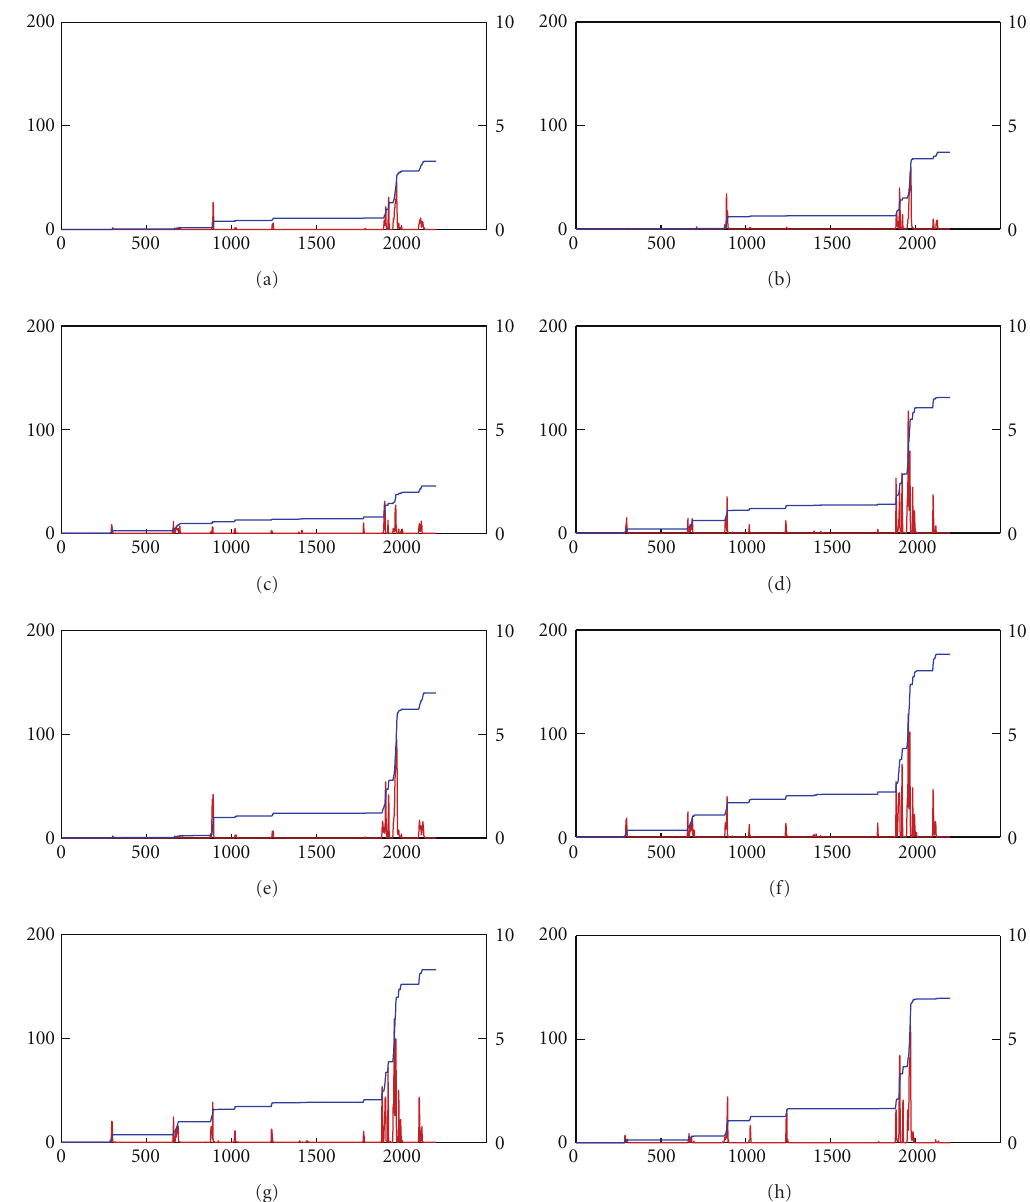
Figure 7: Time-series of hourly rainfall averaged over box (i) in Figure 2(a) for 1 November 2009–31 January 2010 for di ff erent sets of runs. Red and blue curves are the instantaneous and cumulative rainfall, respectively. The top 4 panels correspond, in the same order, to the 4 panels shown in Figure 2 (panel a in Figure 6 corresponds to panel a in Figure 2, etc.). The bottom 4 panels correspond to the 4 panels